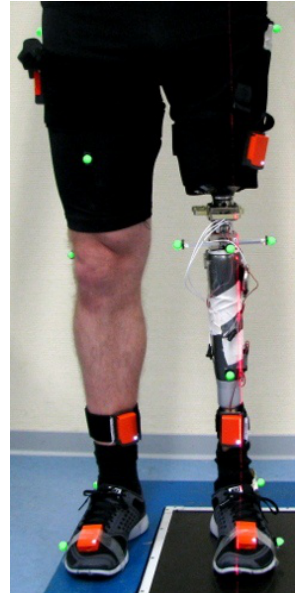
Figure 7. Placement of inertial measurement units and optical markers on the legs of a transfemoral amputee. The optical markers are placed at the typical physiological landmarks. The IMUs are attached using body straps without restricting their position or